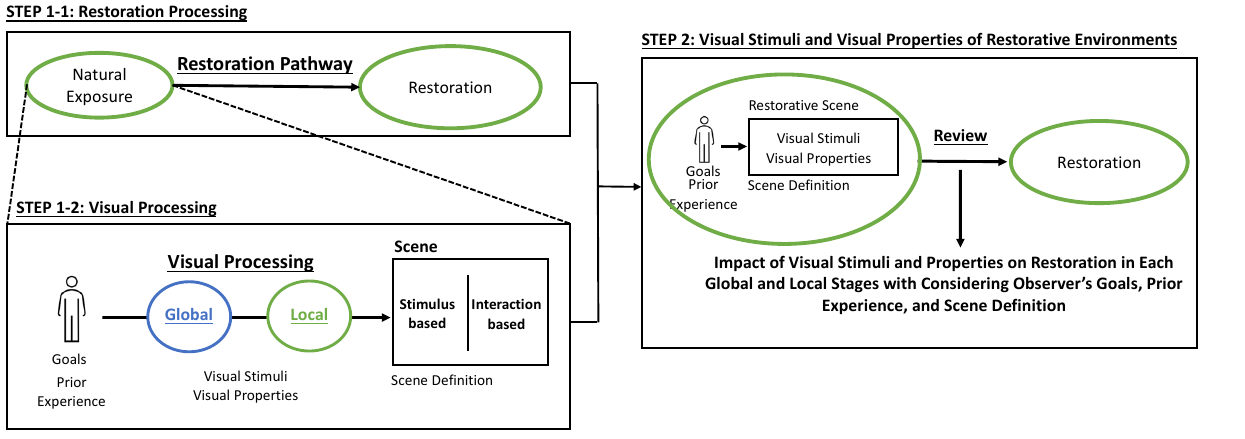
Figure 10. Second step of review based on the restoration path and visual processing framework. Global Visual Processing of the Restorative Scenes